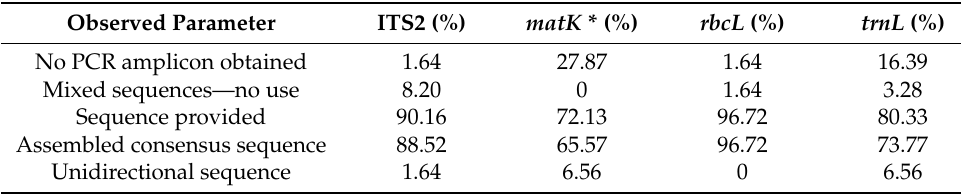
Table 2. Success or failure in each DNA barcoding